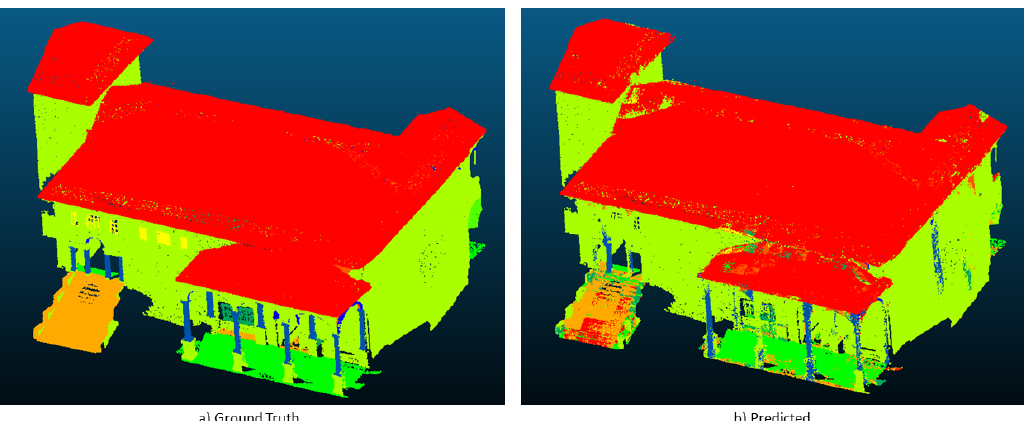
Figure 7. Ground truth ( a ) and predicted Point Cloud ( b ), by using our approach on the last experiment: 9 scenes for Training, 1 scene for Validation and 1 scene for